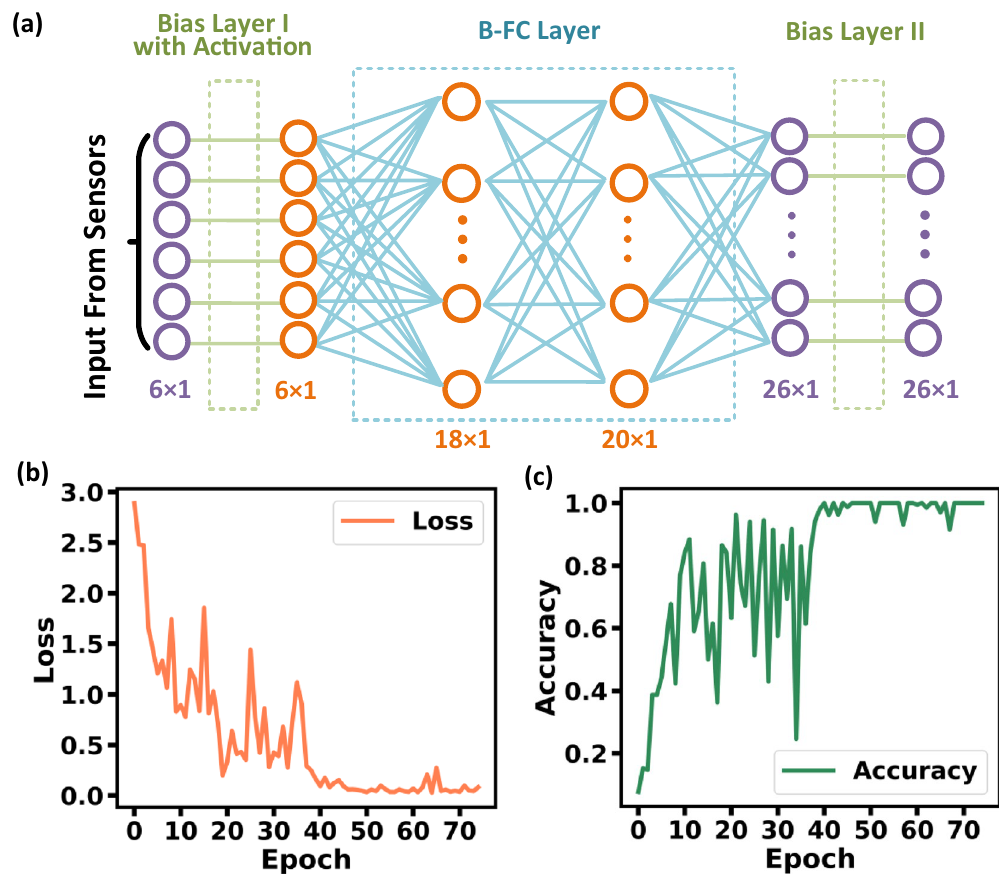
Figure 5. ( a ) Schematic illustration of the BANN structure; ( b ) the loss and ( c ) accuracy of the BANN as a function of number of epochs during the training